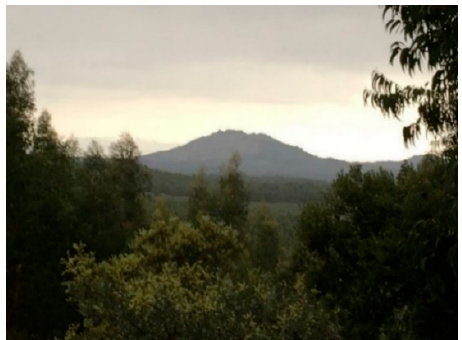
Figure 3. Naturtejo UGGp, Portugal—Landscape view at the Peony Festival.